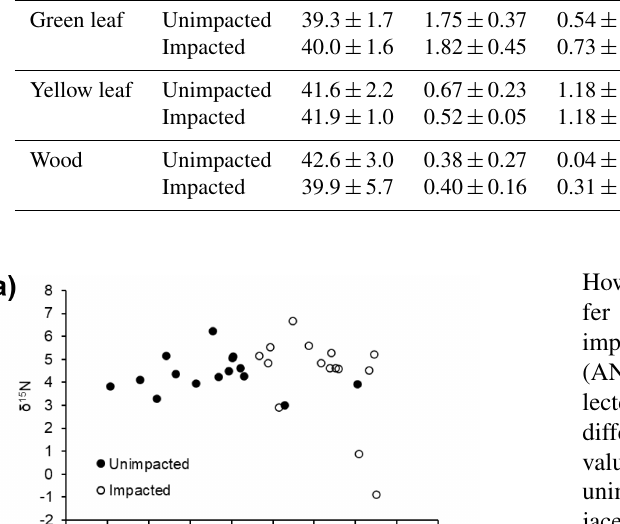
Table 2. Elemental and isotopic compositions of the mangrove A. marina (mean, SD) in 2018, 32 months after the dieback. Tissue type